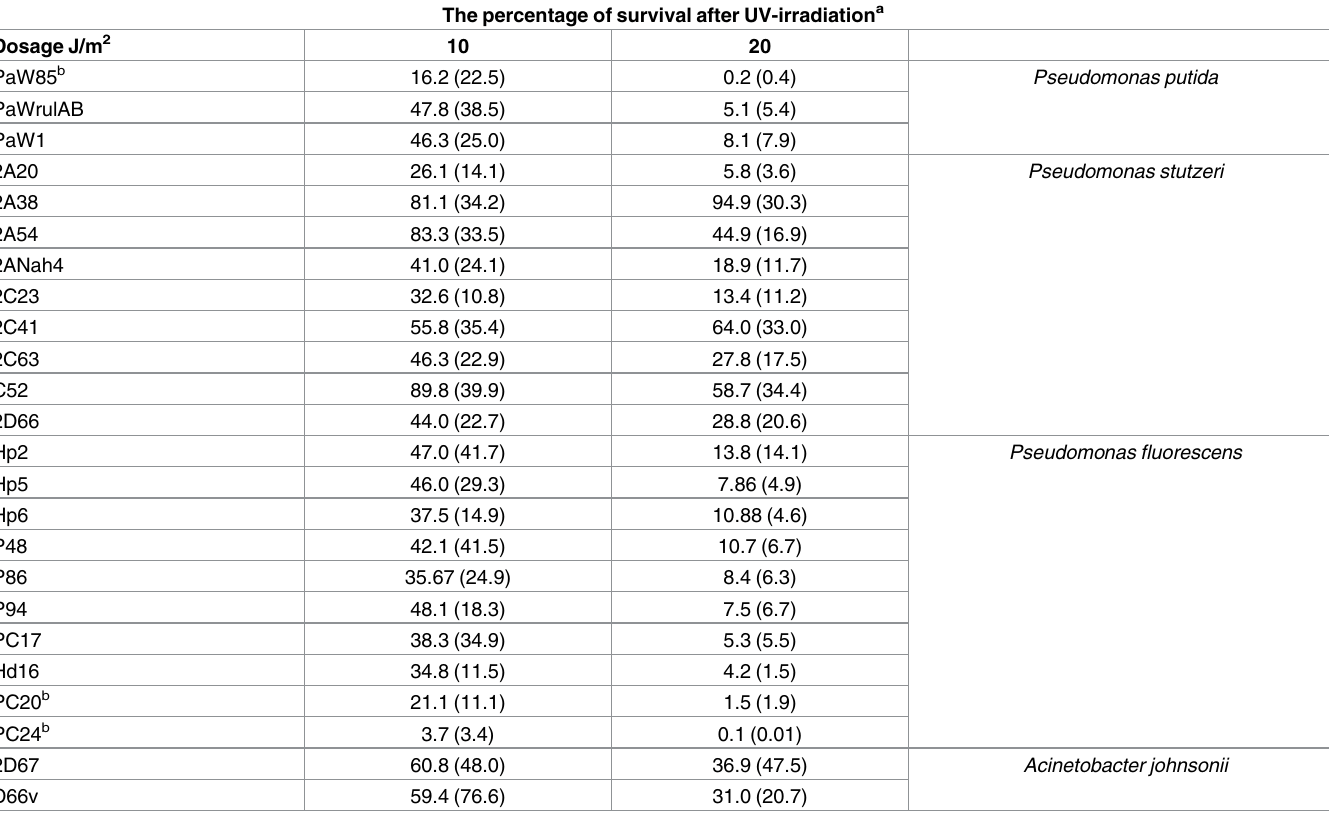
Table 2. UV-C irradiation tolerance of indigenous